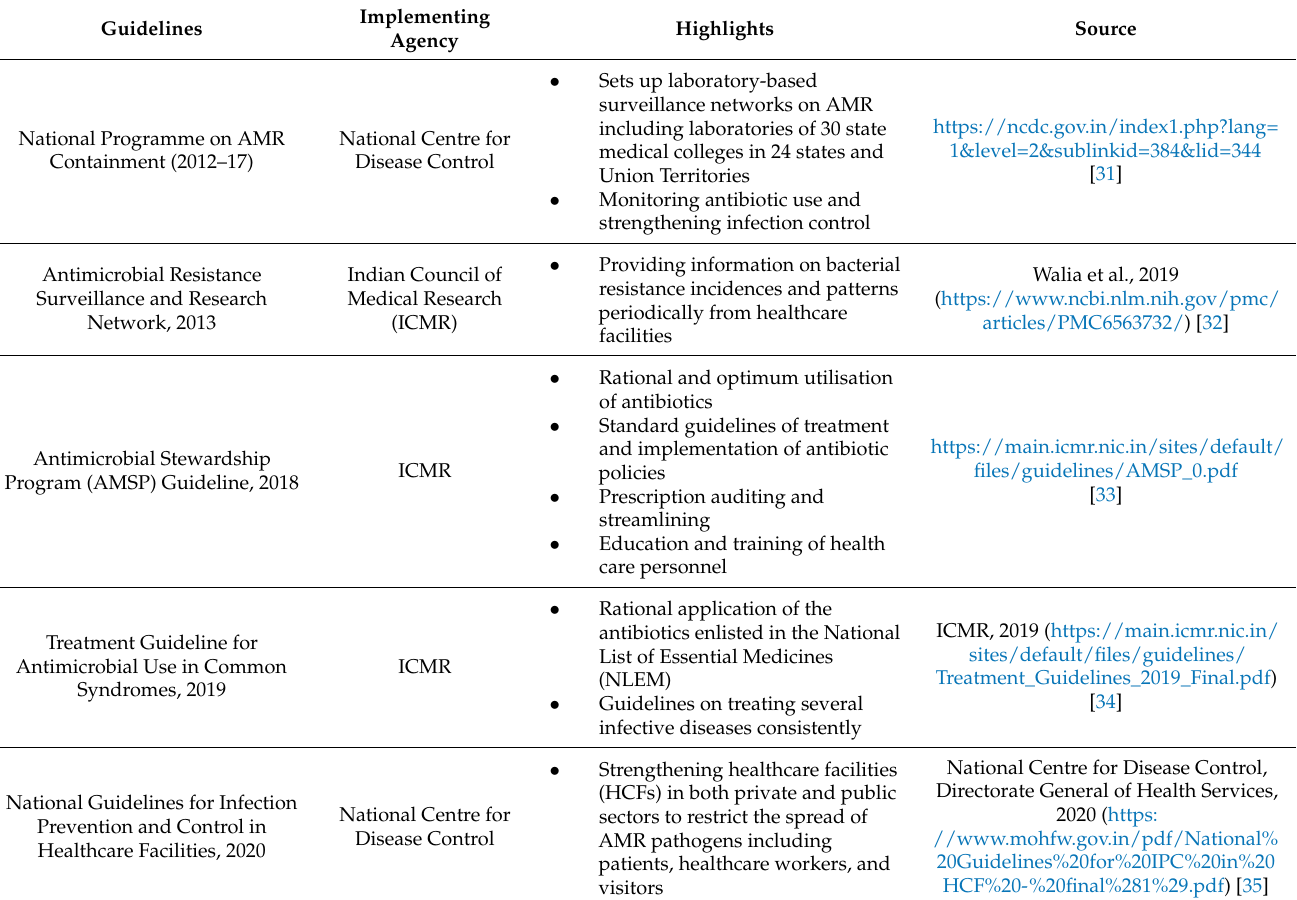
Table 3. Guidelines on the rational use of antibiotics on human